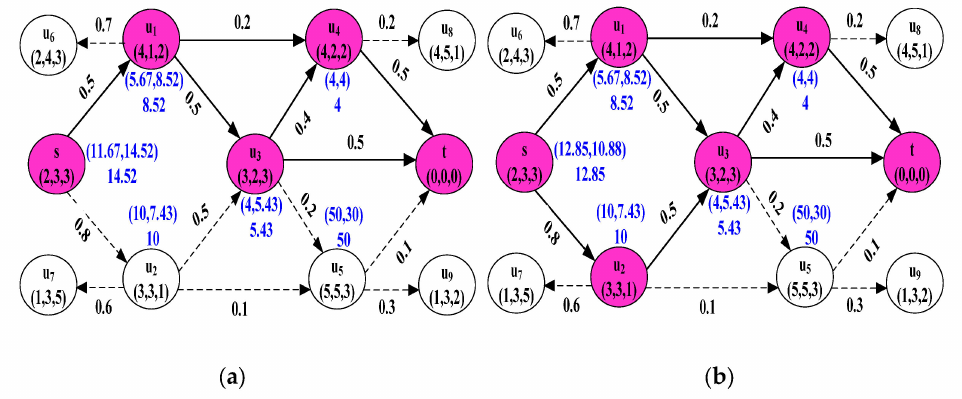
Figure 2. ( a ) Anypath P s ∗ by HMAA and ( b ) optimal Anypath P sopt